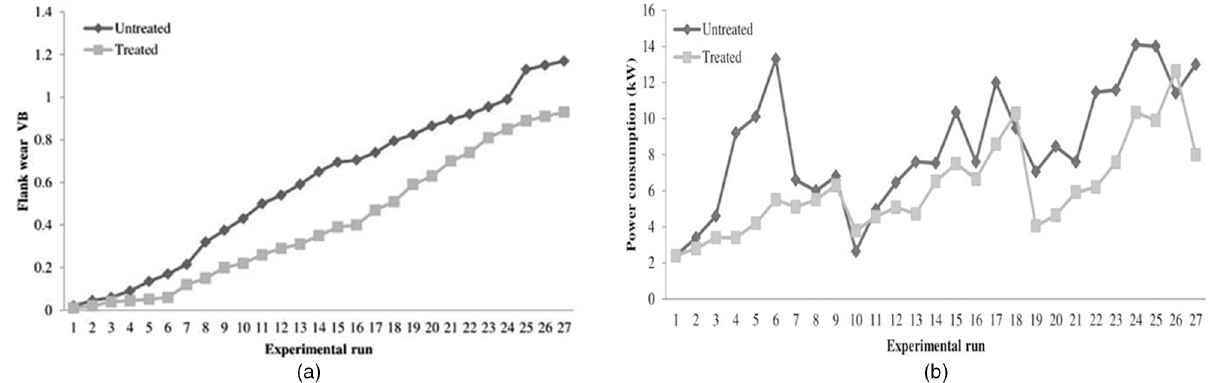
Fig. 9. A graphical representation of variation in fl ank wear (a) and power consumption (b) for each experimental